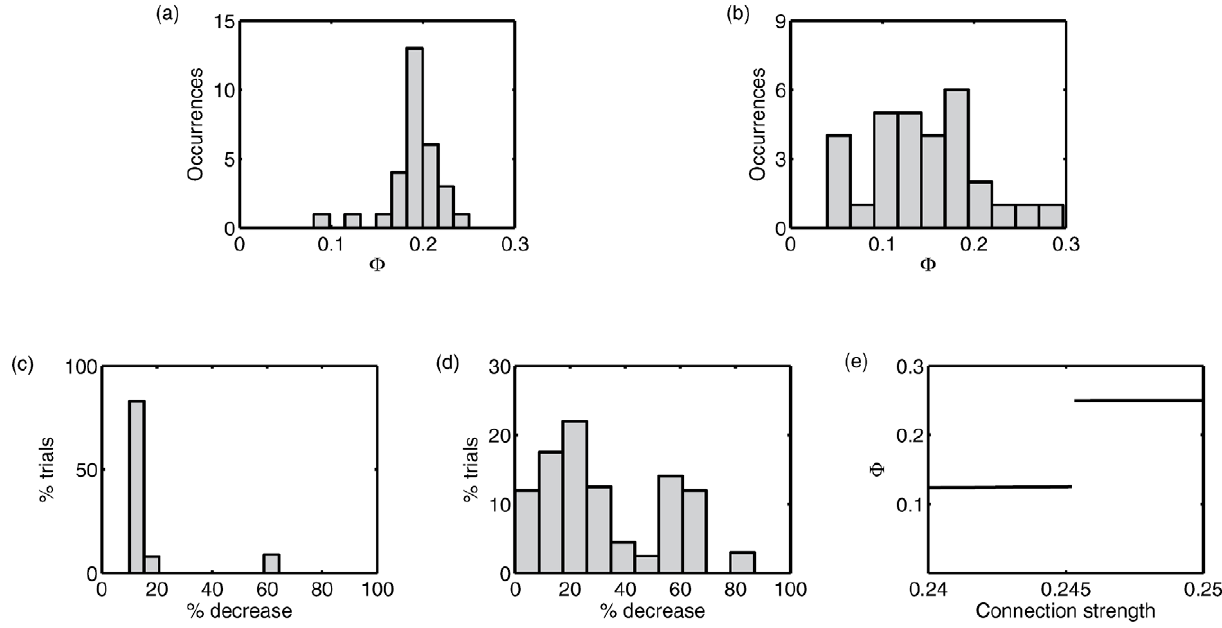
Figure 3. Examination of the W E landscape with respect to network connectivity. (a) Histogram of W E for the 30 networks in the final population of a GA that yielded optimal network 2(a). (b) Histogram of W E for the 30 networks in the final population of a GA that yielded optimal network 2(b). (c) Histogram of percentage decrease in W E following single mutations of network 2(a) (200 evaluations). (d) Histogram of percentage decrease in W E following single mutations of network 2(b) (200 evaluations). (e) Discontinuity in W E as connection strength from element 6 to element 1 continuously changes (network 2(a); (all other connections fixed at 0.25)).